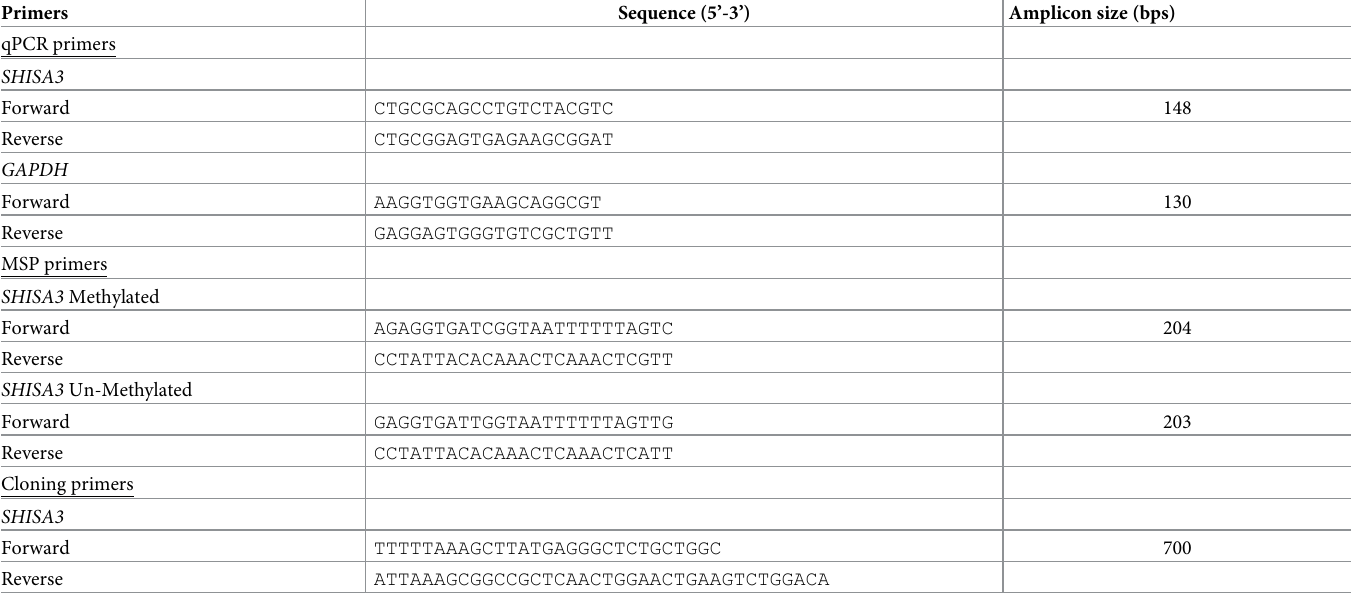
Table 1. List of all primers used in the